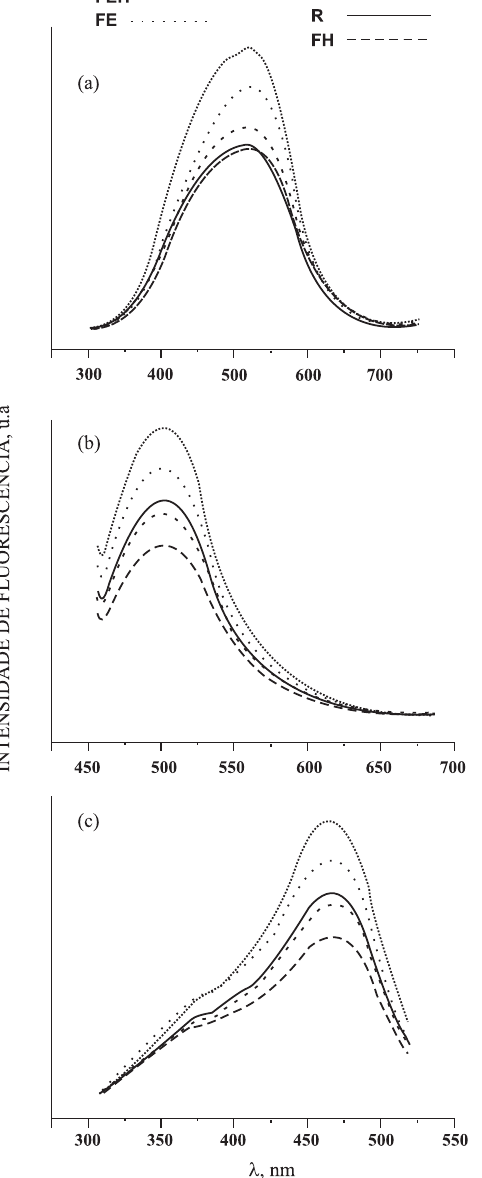
Figura 2. Espectros de fluorescência bidimensionais no modo de emissão, com excitação em 240 nm dos ácidos húmicos (a); com excitação em 465 nm dos ácidos húmicos (b); varredura síncrona com ΔλΔλΔλΔλΔλ de 55 nm dos ácidos húmicos (c). F - Fertirrigação com fertilizantes minerais (uréia, fosfato monoamônico, cloreto de potássio); FE - F + aplicação de 20 dm 3 / planta de esterco antes do plantio e antes da primeira poda de frutificação; FH - F + fertirrigação com 30 dm 3 ha -1 de Codahumus 20; FEH - FH + aplicação de 20 dm 3 de esterco / planta antes do plantio e antes da poda de frutificação; R - testemunha, sem absorção foi o mesmo dos exibidos nos espectros de emissão com excitação em 240 nm (Figura 2a).